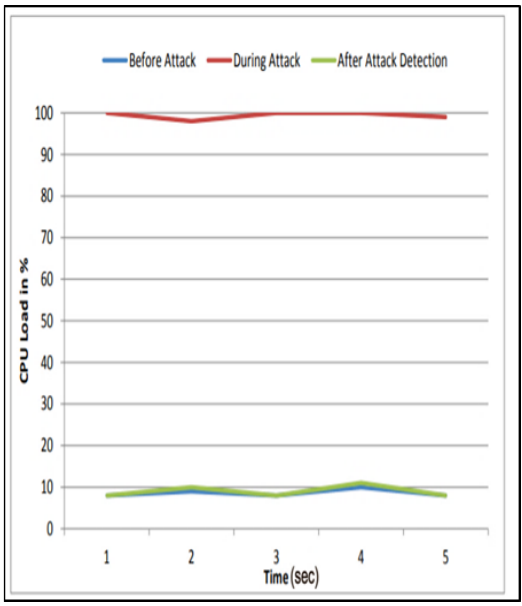
Fig.8 CPU Load of the detection